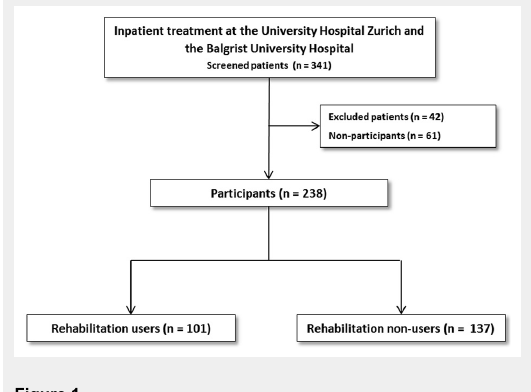
Flowchart of study participants vs nonparticipants, rehabilitation users vs rehabilitation